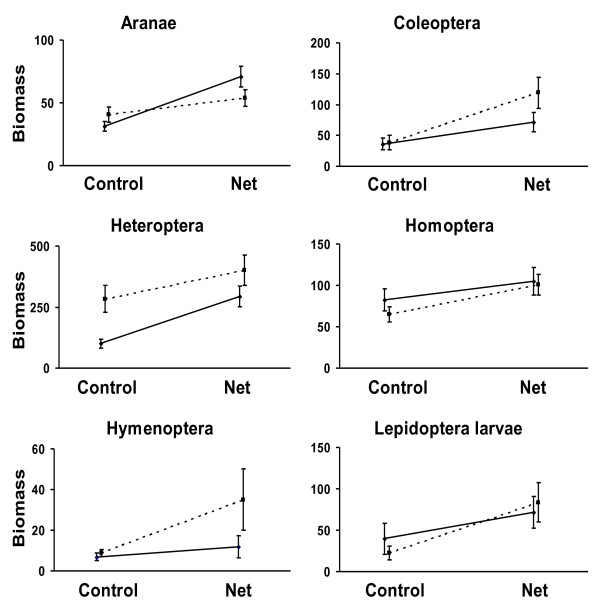
Arthropod biomass. Arthropod biomass (g wet arthropod biomass/kg wet leaf mass ± S.E.) of the six largest orders in relation to experimental treatment and management (dotted line = dense understory, full line = understory clearance).